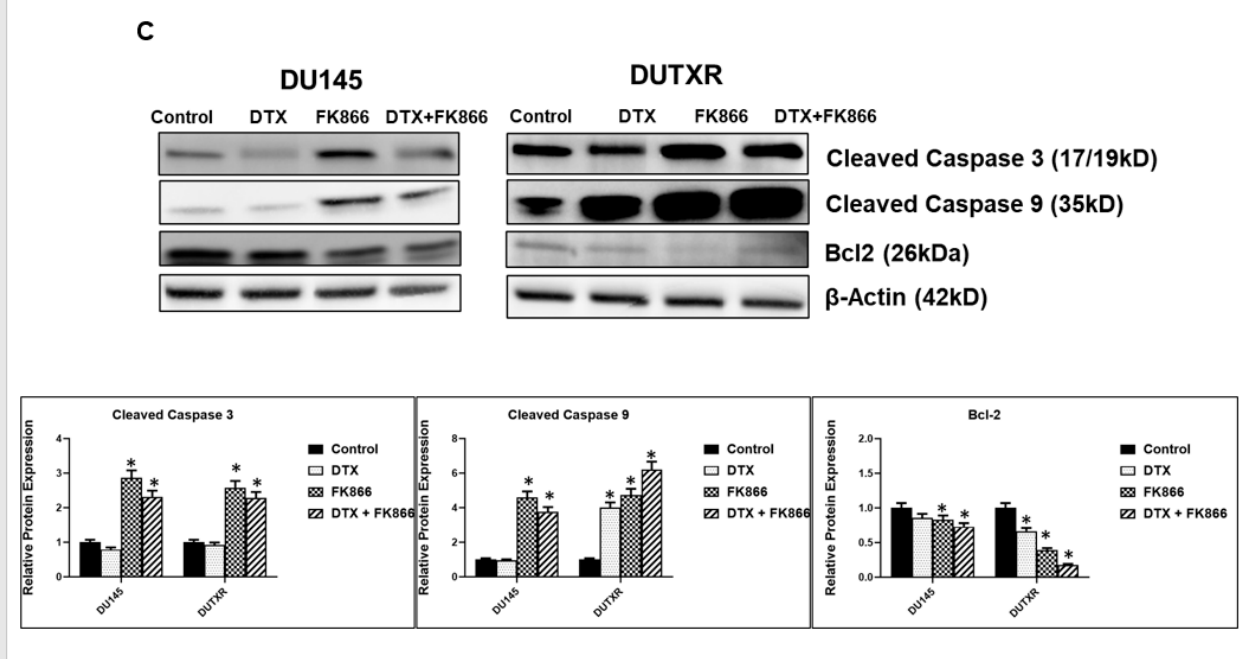
Figure 4. FK866 induces apoptotic cell death in lethal PCa. ( A ) Representative figures showing Annexin-V positive cells measured using flow cytometry following FK866 single-agent and DTX + FK866 combination treatment; bar plot shows higher apoptosis in combination treatment compared to single-agent treatment. (Significance p -value * = p < 0.05.) Apoptosis was confirmed using ( B ) Caspase-3/7 enzyme activity assay and ( C ) Western blotting and Densitometry analysis showing protein expression of cleaved caspase 9, cleaved caspase 3 and Bcl-2. Representative plots showing DU145 and DUTXR lines are presented. Similar results were obtained for all metastatic PCa cell lines. (Significance p -value * = p < 0.05.) Original uncropped western blot images are provided in Supplementary Figure S8.